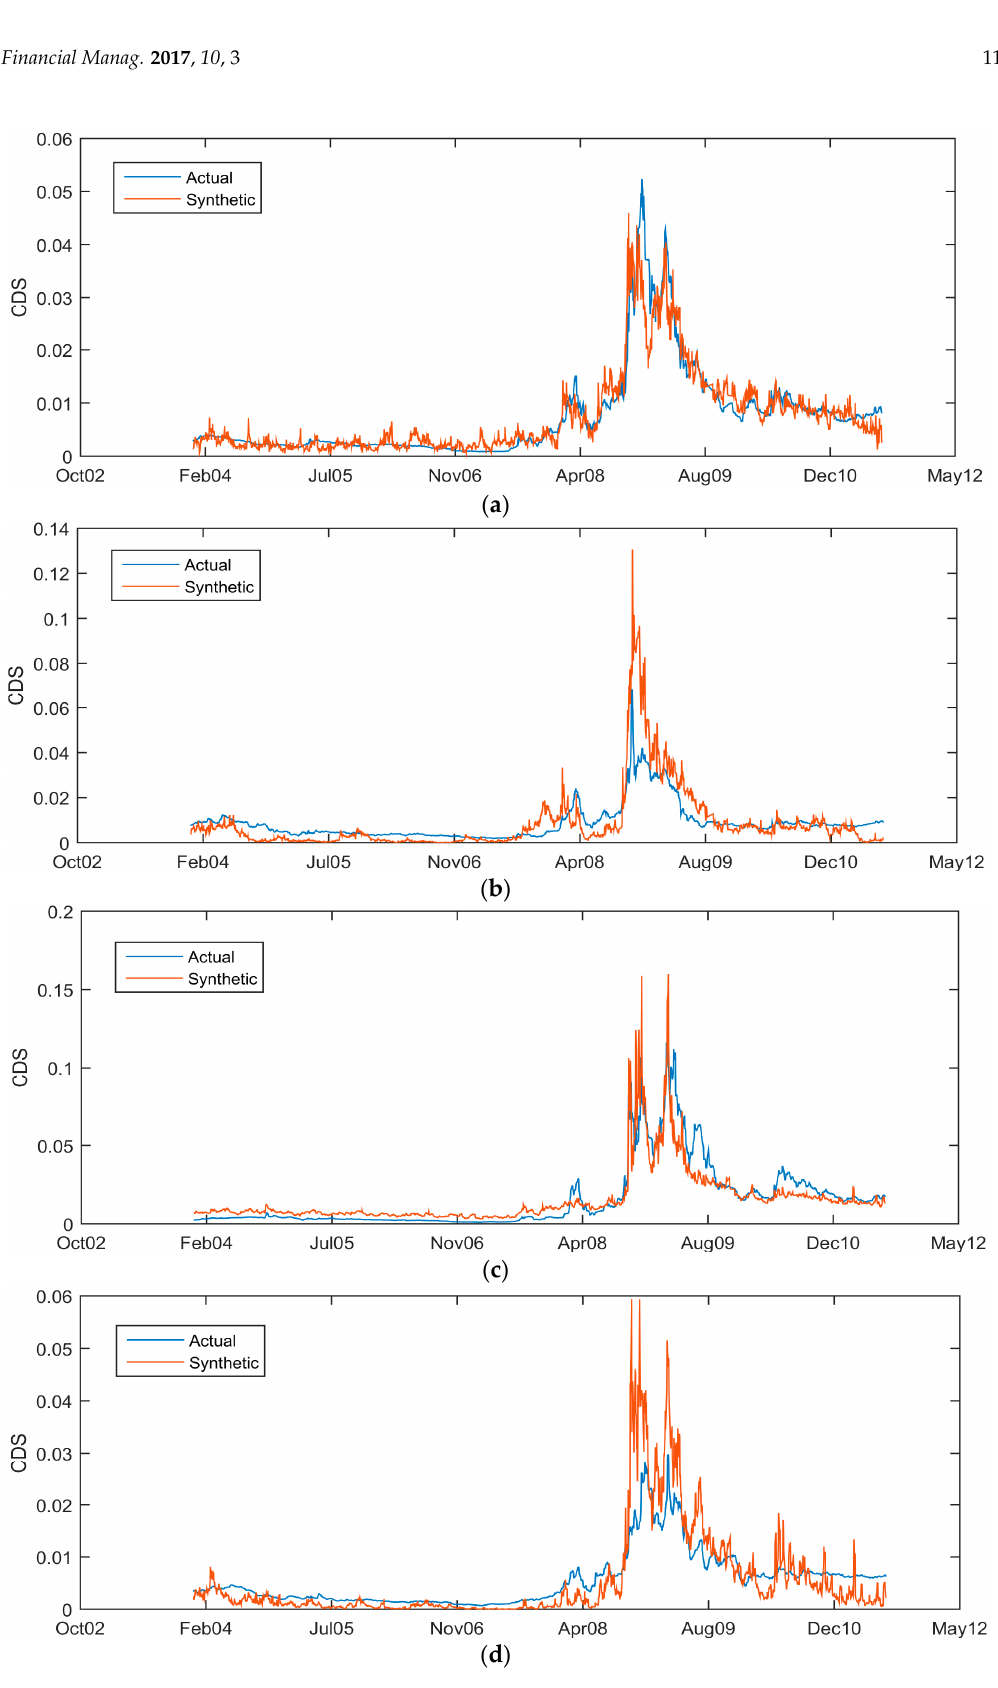
Figure 6. Synthetic Credit Default Swap (CDS) versus traded five-year CDS for: ( a ) BMW; ( b ) Hutchison Whampoa; ( c ) Hartford Financial Services; ( d ) Boeing Co.